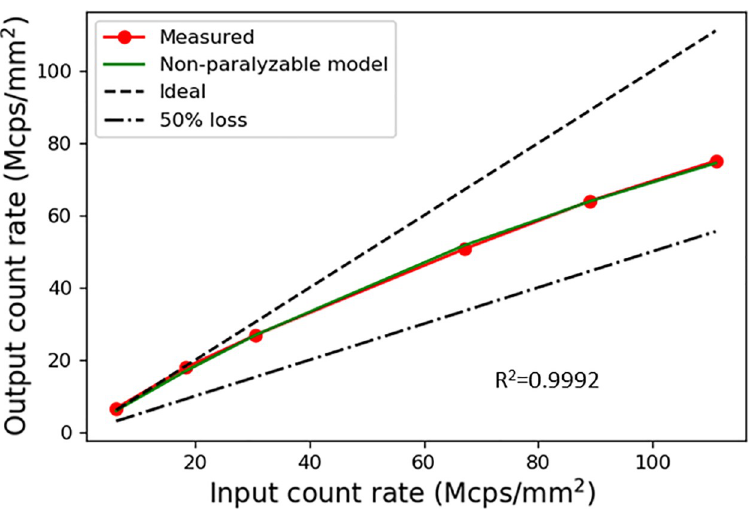
Fig 10. Count rate performance of the CdTe detector. The output count rates were obtained by averaging the 25 detector pixels. The count rate was recorded as a function of input count rate (5, 15, 25, 55, 73, and 91 mA) for 120 kVp tube voltage, and 1 s data acquisition